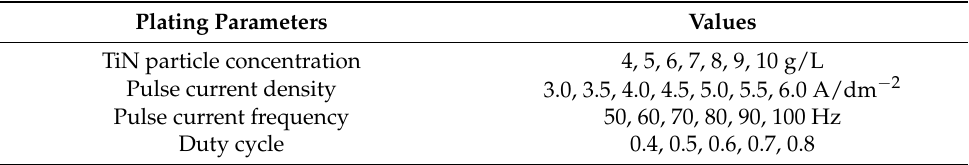
Table 2. Some typical plating parameters to validate the BP model.